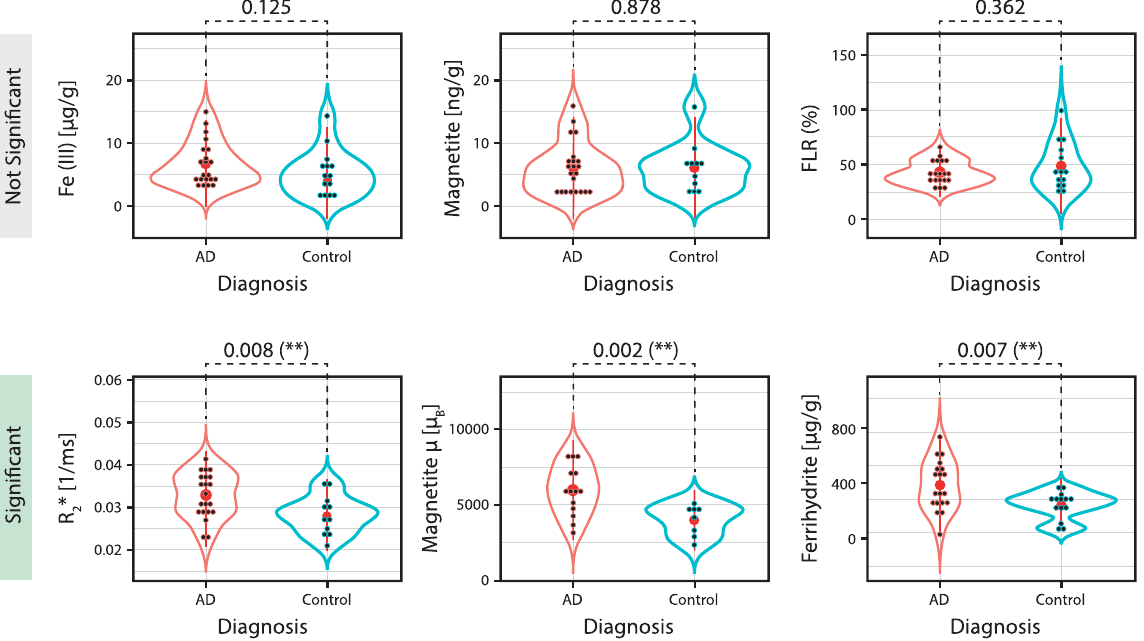
Figure 4. Violin plots of the measured iron forms and their magnetic properties. Experimental data, i.e. iron form concentrations and magnetic moment, grouped by diagnosis (AD and control). Each plot shows individual data (black dots), the mean (red dot) and the histogram of the data (curve line). The number on top of the data is the p-value obtained from the Student’s t-test performed on the two groups. “Significant” indicates a p-value less than 0.05. The top row represents the iron forms and property showing a not significant result, while the bottom row represents the significantly different iron forms. The double asterisk ( ** ) signifies that the p-value is less than